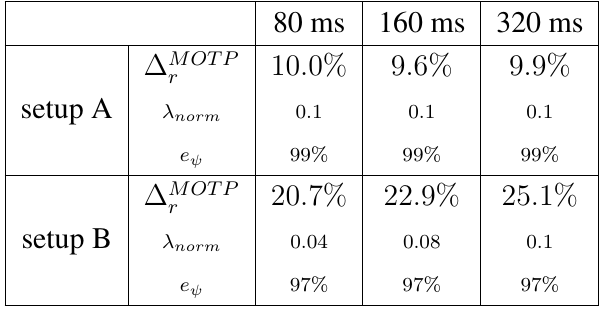
Table 6. Relative improvements of MOT P ( m ) for sequence seq02 , using the optimal parameter values estimated for sequence seq01 .